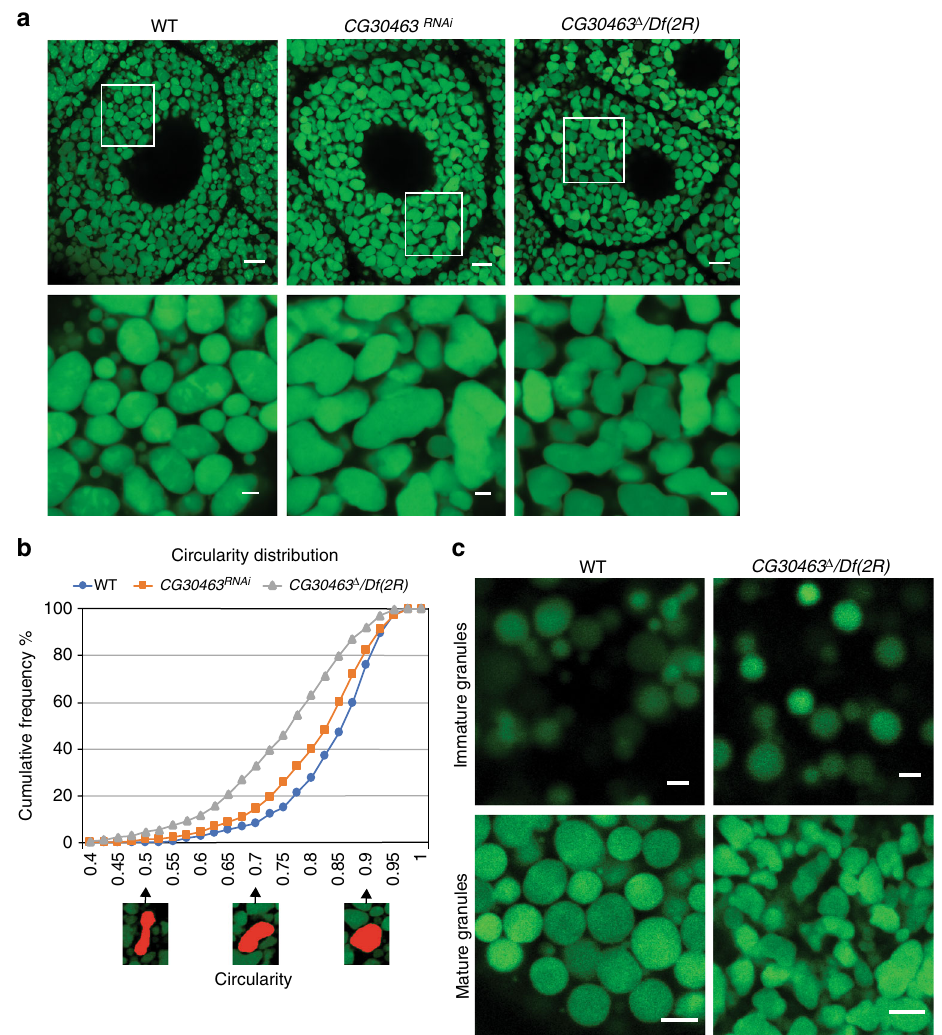
Fig. 1 Irregular secretory granule morphology in the absence of CG30463 . a Confocal images of third instar larval salivary glands (SGs) expressing Sgs3- GFP cargo (green) in secretory granules. Wild type secretory granules (WT ) are round or oval in morphology while granules in SGs expressing RNAi to CG30463 ( CG30463 RNAi ) or de fi cient for CG30463 ( CG30463 Δ /Df(2R) ) are no longer round but have an angular, shard-like morphology. The white boxed area in the upper panels is enlarged below each image. Representative images from three independent experiments are shown. Scale bars, 10 μ m for the upper panels and 2 μ m for the lower panels. b Secretory granule circularity for WT, CG30463 RNAi , and CG30463 Δ /Df(2R) was calculated using the Nikon imaging software. Curves representing cumulative frequency of granule circularity for each genotype are shown. Images of secretory granules corresponding to circularity values of 0.5, 0.7, and 0.9 are shown below the x -axis. Granule circularity quanti fi cation was performed on granules from three individual salivary glands from each of three independent biological replicates of each genotype. Values were normalized by total number of granules ( n = 815 for WT; n = 899 for CG30463 RNAi ; n = 841 for CG30463 Δ /Df(2R) ). c Confocal images of secretory granules expressing Sgs3-GFP in proximal (Immature Granules) or distal (Mature Granules) secretory cells of early third instar larval salivary glands from WT and in the absence of CG30463 ( CG30463 Δ /Df(2R)) . Scale bars, 1 μ m for the upper panels and 5 μ m for the lower panels. Representative images from three independent experiments